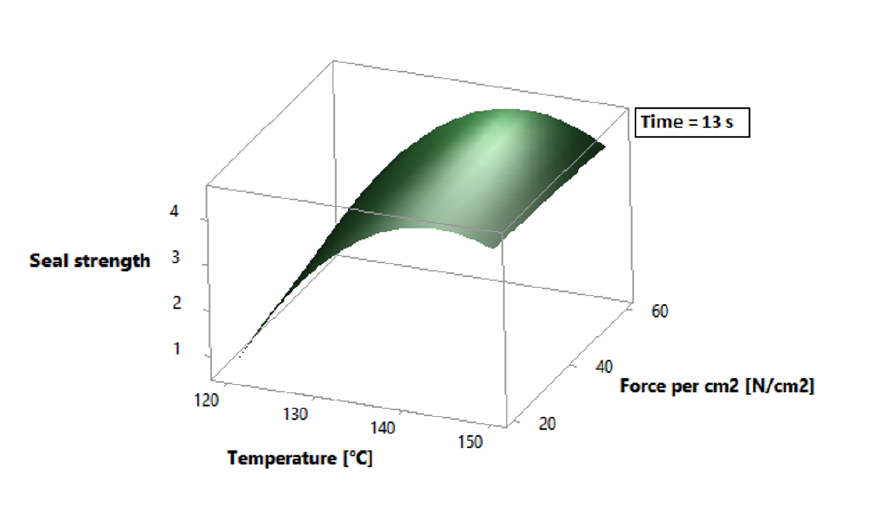
Figure 6 – Surface plot of Seal strength vs. Force per cm 2 and Temperature.